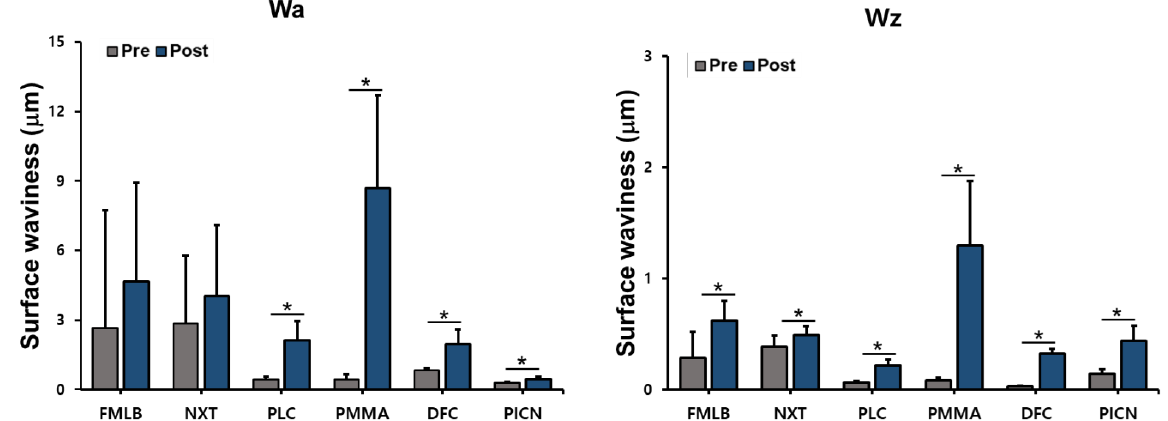
Figure 4. Surface waviness (Wa, Wz; data are mean and standard-deviation values) of six materials pre and post artificial toothbrushing. Asterisks indicate statistically significant differences ( p < 0.05).